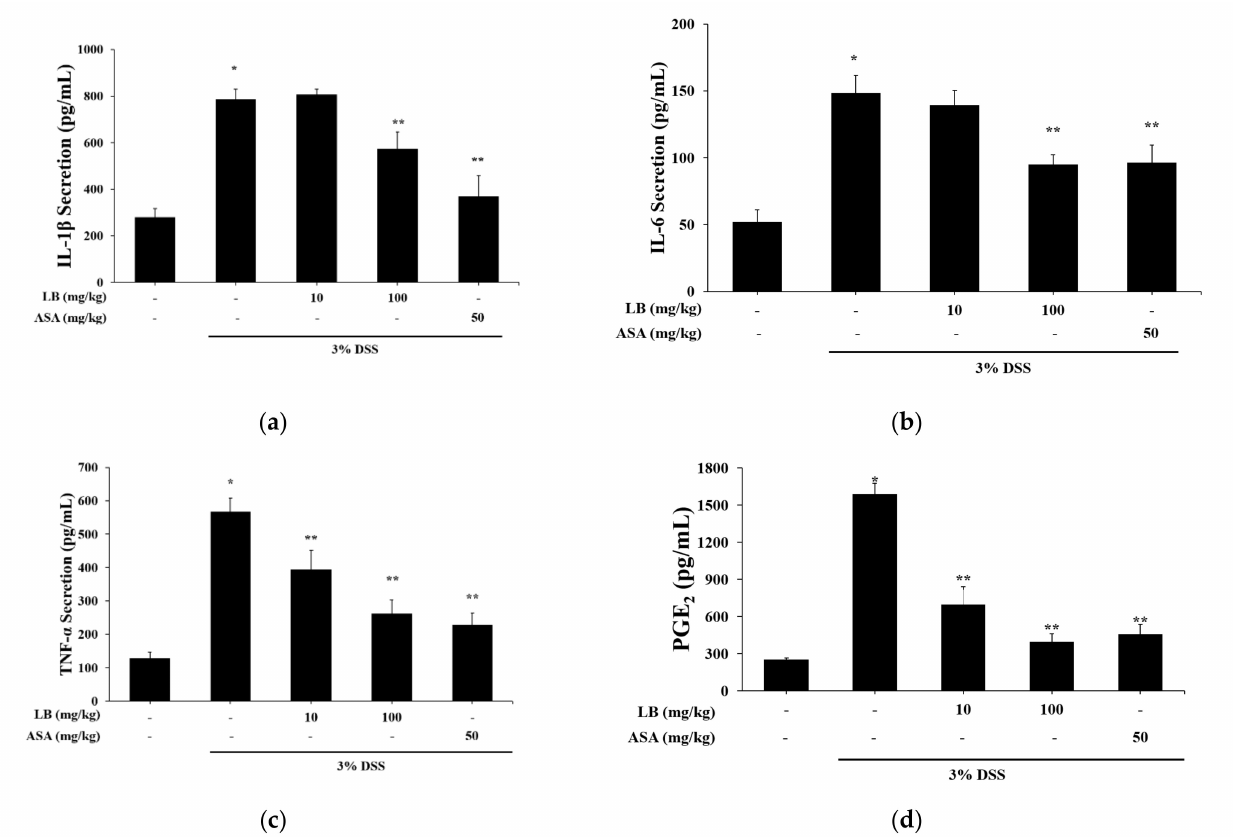
Figure 3. In DSS-induced mouse serum, LB significantly decreased the secretion of inflammatory cytokines (( a ) IL-1 β , ( b ) IL-6, and ( c ) TNF- α ). The LB treatment also considerably suppressed ( d ) PGE 2 expression in the colon tissue. Values are represented as the mean ± S.D. The data were analyzed by Bonferroni’s post-hoc test. * p < 0.05 versus Blank group and ** p < 0.05 versus DSS